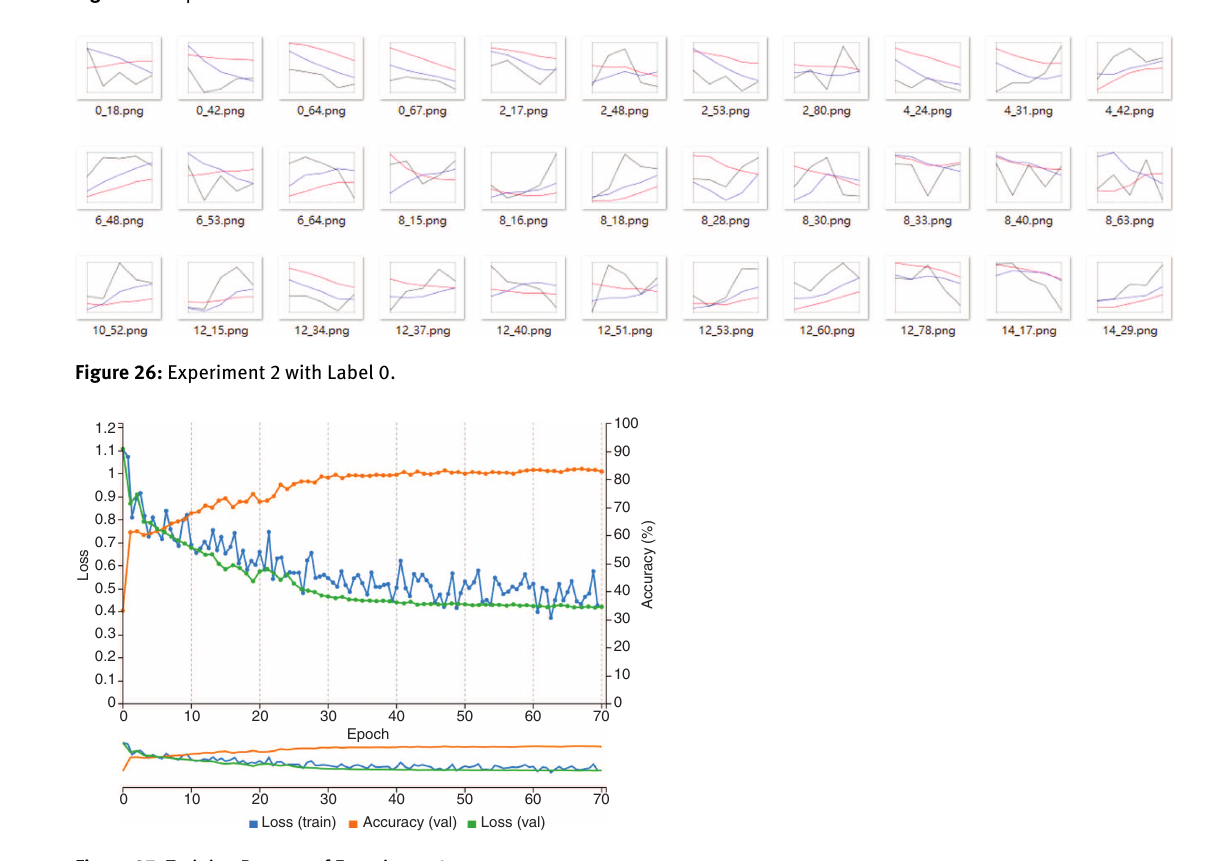
Figure 25: Experiment 2 with Label − 1.